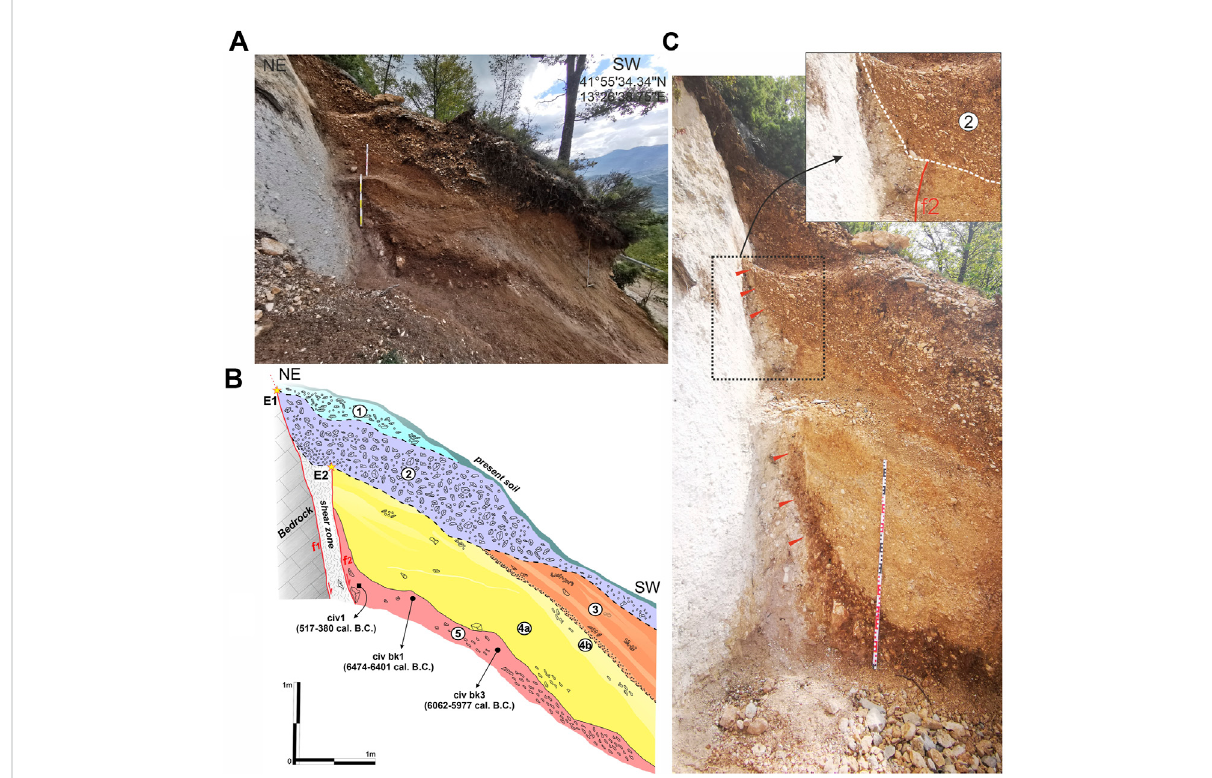
FIGURE 13 (A) Wall of the excavation made at the “ Grotta di San Bartolomeno ” site. (B) Stratigraphic scheme of the excavation walls. (C) Details of the fault zone; evidence of dragging of the deposits along the fault plane is marked by red arrows. The inset shows the basal contact of Unit 2, marked by a white dashed line, cross cutting, and sealing the